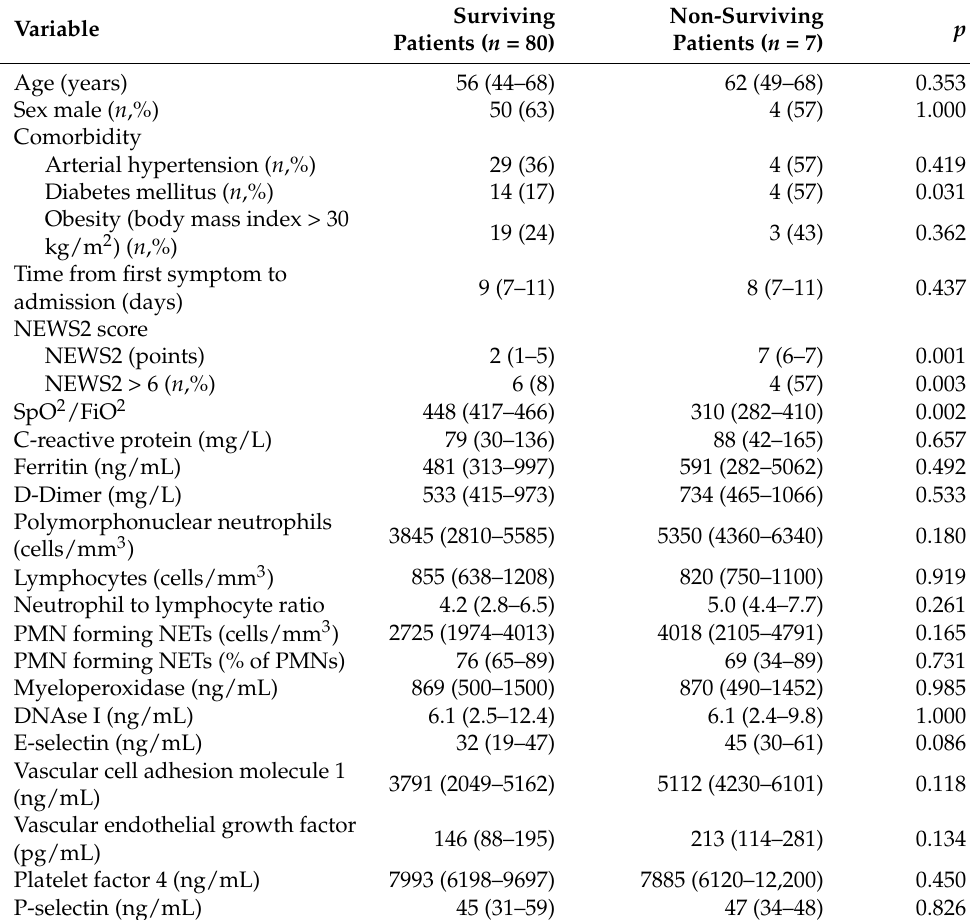
Table 3. Baseline characteristics of patients with pneumonia by SARS-CoV-2, grouped by